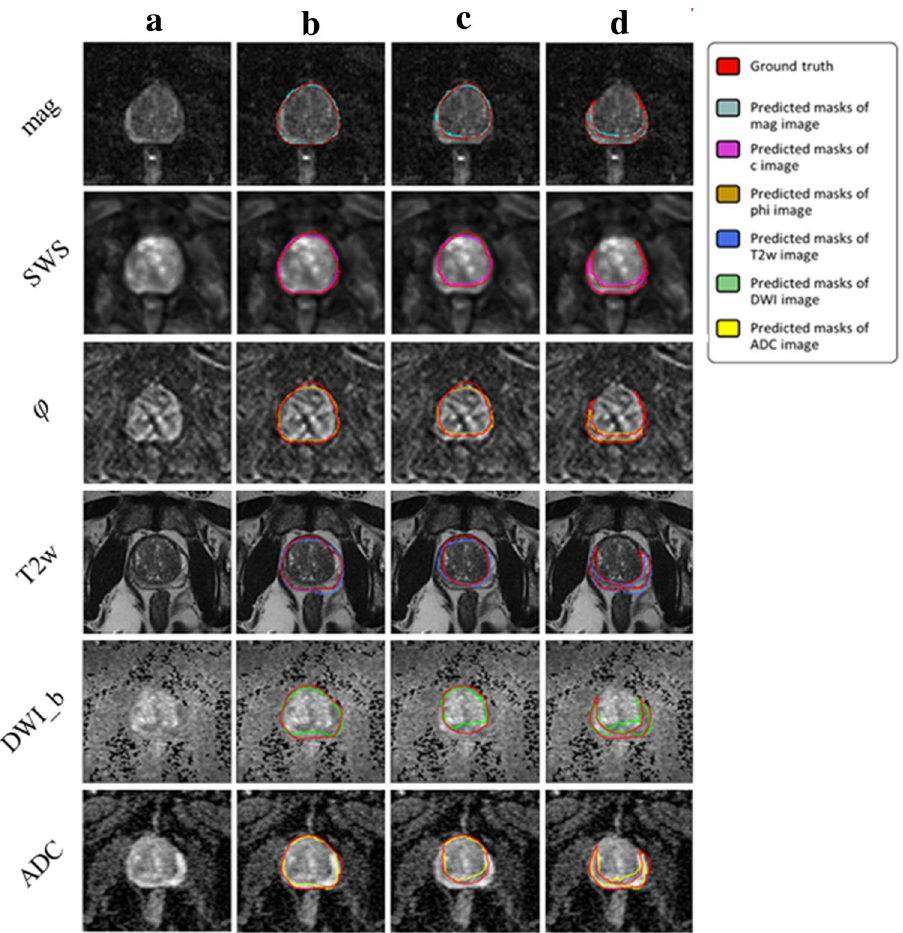
Figure 5. Examples of segmentation results achieved with IMs: first column ( a ) shows the original image, second ( b ), third ( c ) and forth column ( d ) show masks of prostate, central and peripheral zones,